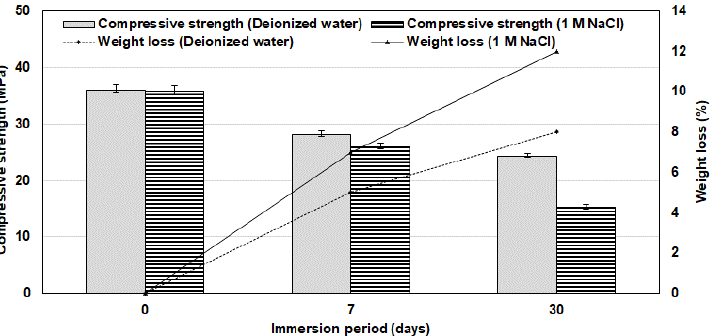
Figure 7. Evolution of compressive strength and weight loss of MW/MK 0.3 AAM after immersion in deionized water and 1 mol/L NaCl solution for 7 and 30 days.